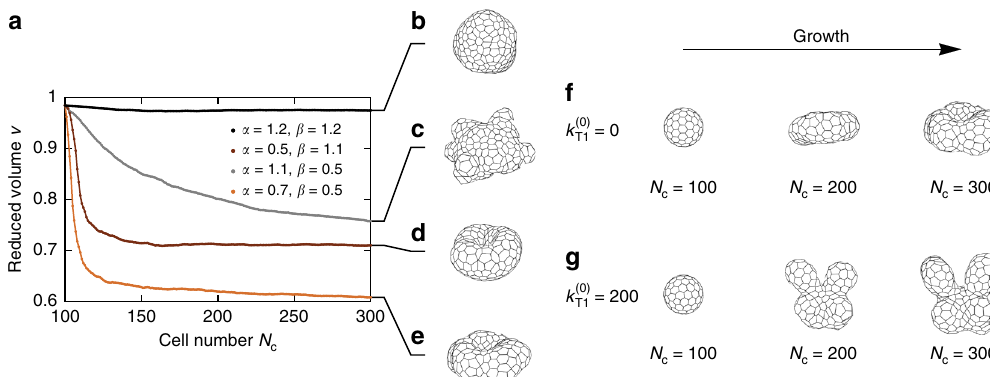
Fig. 4 Model of growing epithelial shells. a Reduced volume of growing shells as a function of cell number, based on 25 instances. b – e Shell shapes at N = 300 and ( α , β ) = (1.2, 1.2), (1.1, 0.5), (0.5, 1.1), and (0.7, 0.5), respectively. f Growing shell with ( α , β ) = (0.7, 0.5) at 100-, 200-, and 300-cell stage c in absence of active T1 transitions. g Growing shell at the same α and β but with active T1